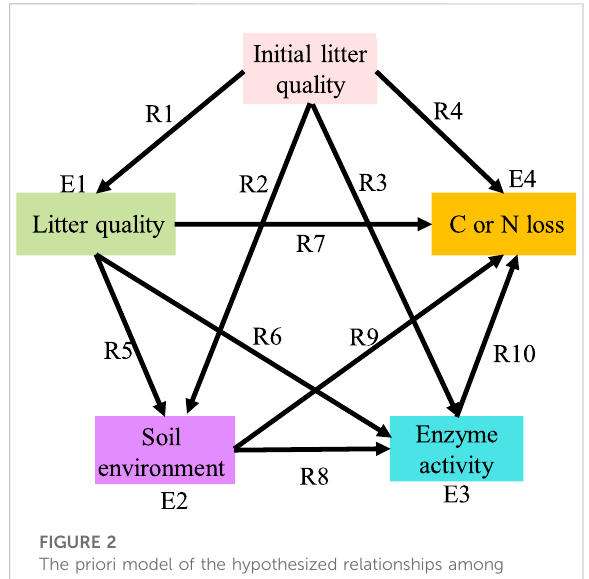
FIGURE 2 The priori model of the hypothesized relationships among initial litter quality, litter quality, the soil environment and soil enzyme activities for litter C or N loss. All measured variables (except for “ initial litter quality ” ) represent temporal dynamics during decomposition. The model was applied to conduct multigroup comparisons among different decomposition stages, and the smoothing groups were selected using 40% mass intervals. The single-headed arrows represent a hypothesized relationship of one variable on another. R is the path coef fi cient, and E is the error variance of a